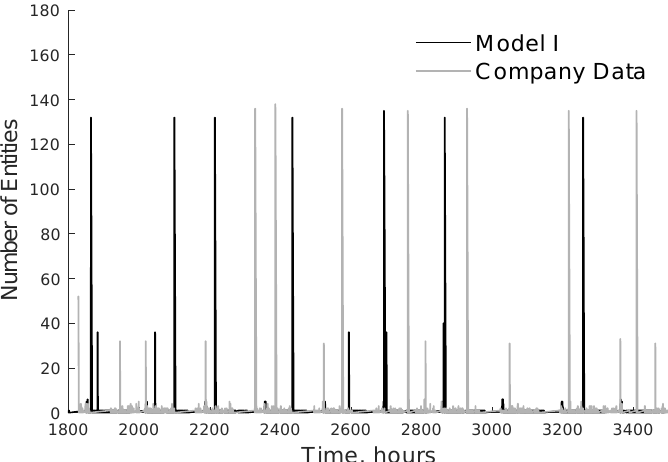
Figure 14. Number of waiting entities to be unloaded at Stage 1. The dark solid line represents results obtained using Model 1, while the grey line shows company data.